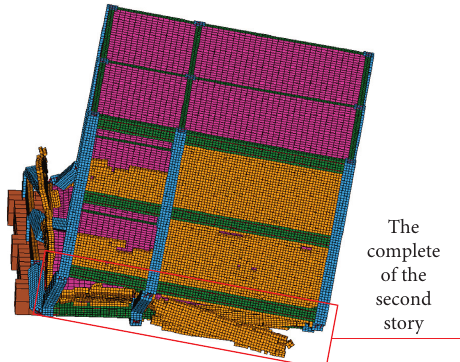
Figure 41: Second-floor collapse of the simulation (right).